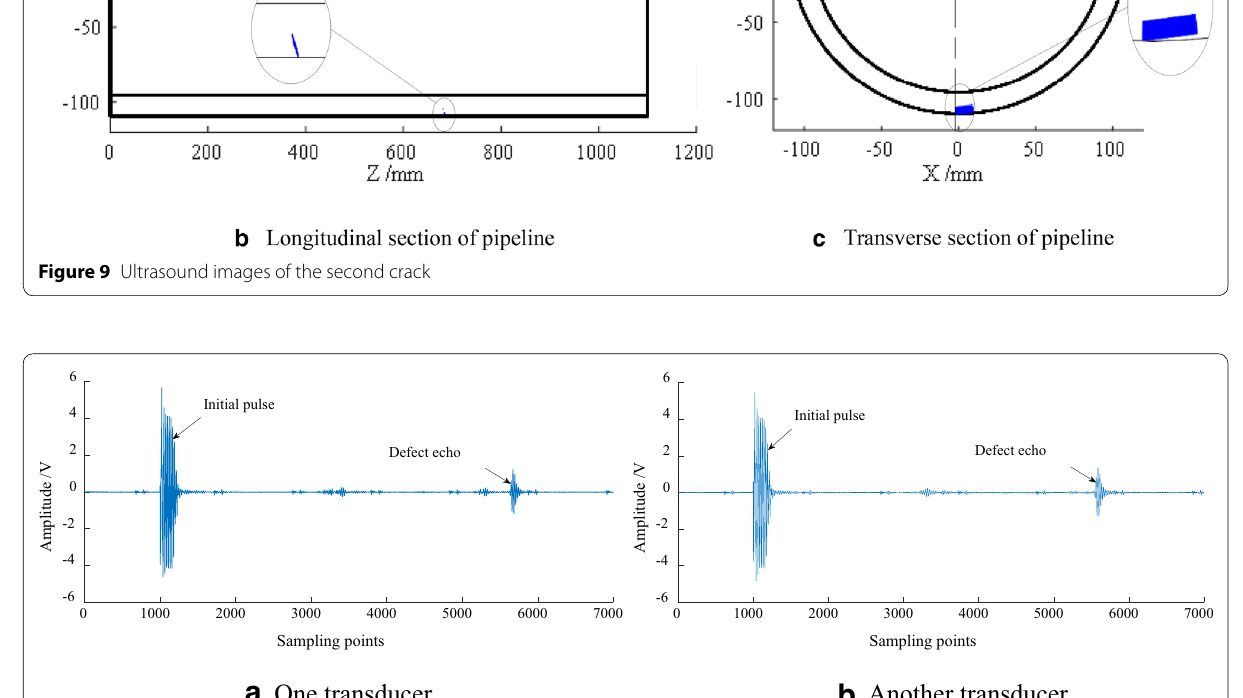
Figure 10 Defect echo signals of the third